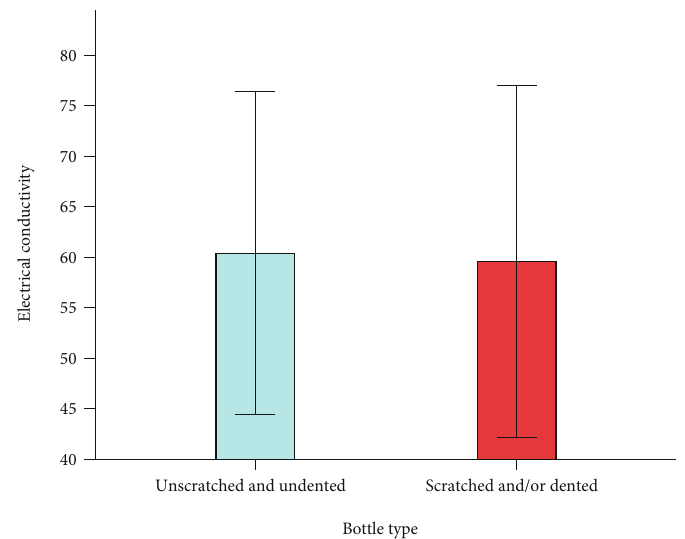
Figure 2: Distribution of the EC value with respect to the physical condition of the bottled water vessel.